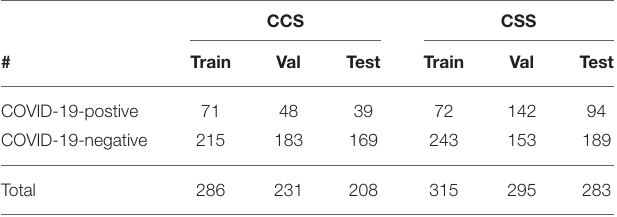
TABLE 2 | DiCOVA sub-challenge dataset